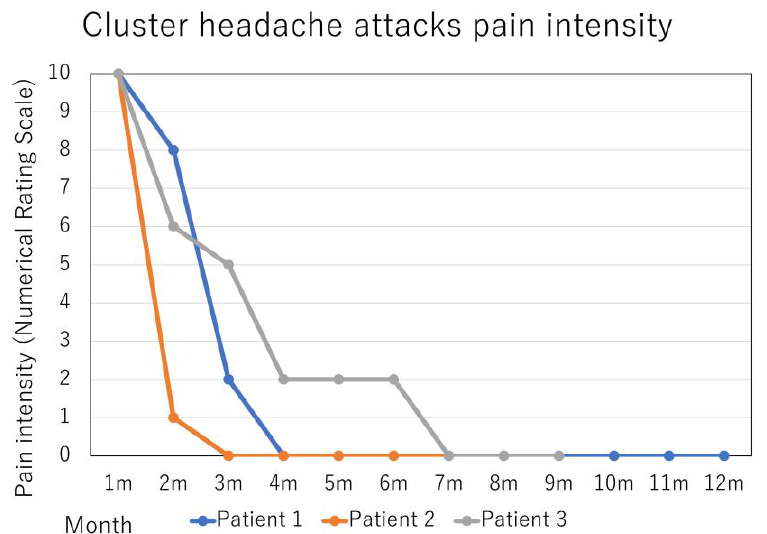
Figure 1. Change in the frequency of cluster headache (CH) attacks in the course of treatment.